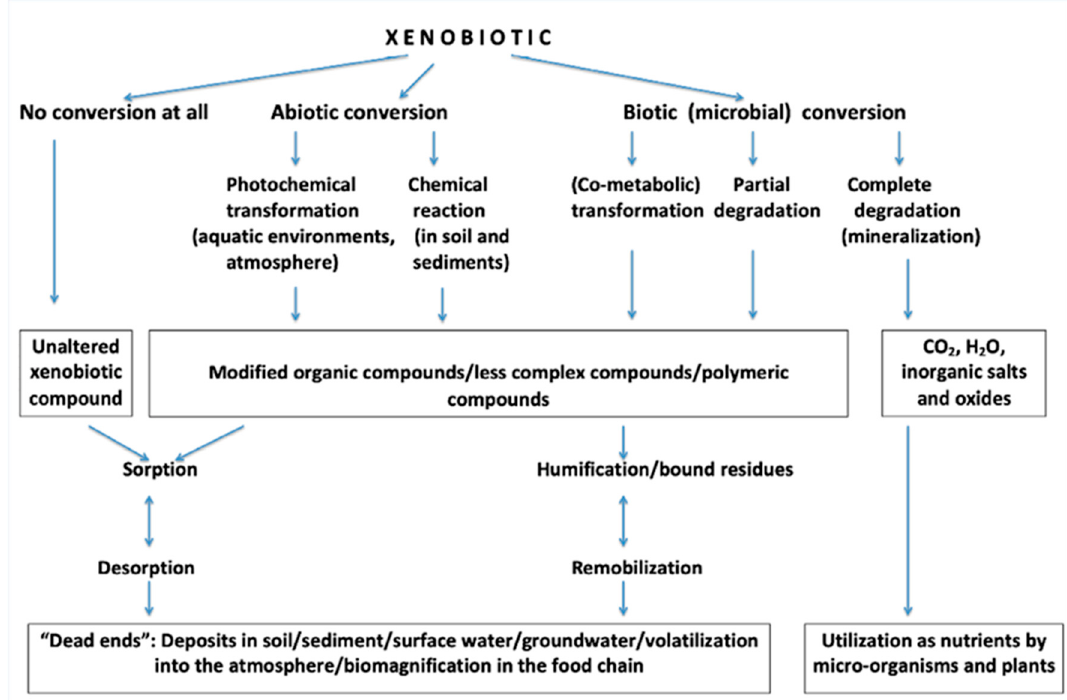
Figure 3. Possible environmental fate of a xenobiotic compound (Reproduced with permission from [5]; published by Springer eBook, 2016).